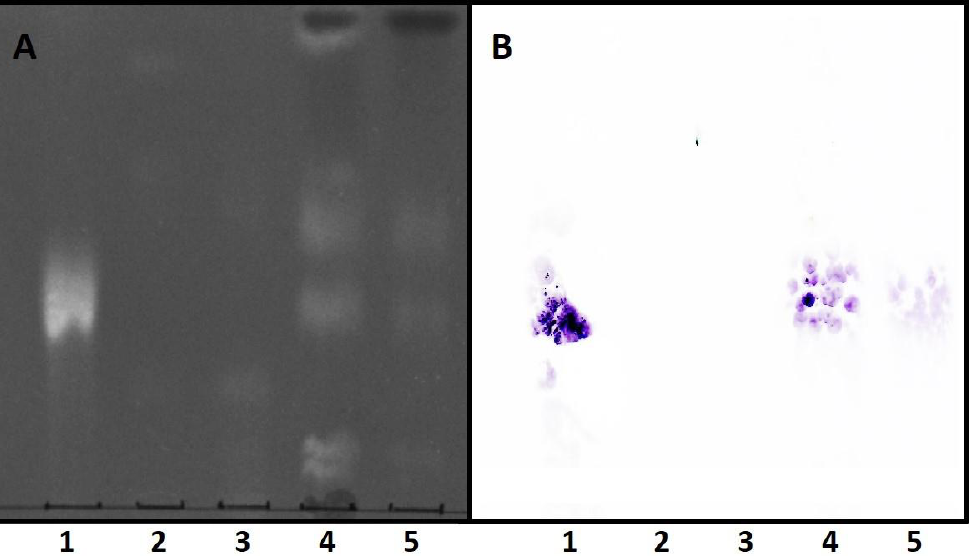
Figure 4. Thin-layer chromatography and immunodetection of CPE-bound EryA. Lipid standard CPE (1) and total lipid extracts from E. coli (2), A. actinomycetecomitans (3), P. gingivalis , nonpolar fraction (4), and P. gingivalis , aqueous fraction (5) were separated on an HPTLC plate with a solvent mixture of chloroform/methanol/25% ammonia (65/25/4 by volume). Primulin reagent was sprayed for detection of lipids under UV light ( A ). The blotted PVDF membrane was incubated with EryA (2 µg/mL) which was immuno-detected using peroxidase-conjugated secondary antibodies ( B ). The specific interaction between EryA and CPE species was further confirmed by a dot blot assay in which EryA-mCherry was applied to commercial sphingolipids, CPE, and SM, as well as to total lipid extracts from P. gingivalis and E. coli . Binding of EryA-mCherry was visible on both CPE-containing samples (commercial CPE and P. gingivalis total lipid extract) but was not observed in the case of SM or E. coli (Figure 5). As in the case of thin-layer chromatography, the relatively weaker binding of EryA-mCherry to the lipid